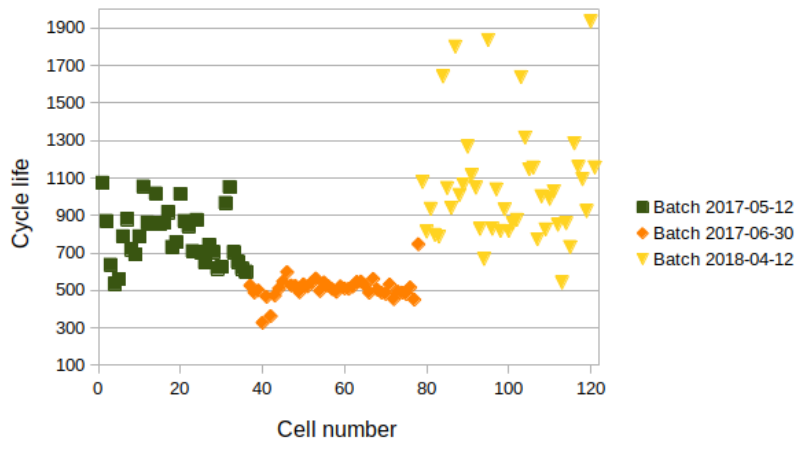
Figure 3. Resulting distribution of cycle lives of all analyzed cells. The different colors correspond to each experimental batch. One difference between the three batches is the resting times while cycling. The cells with the shortest cycle lives belonged to batch “2017-06-30”, which was the batch with the longer resting